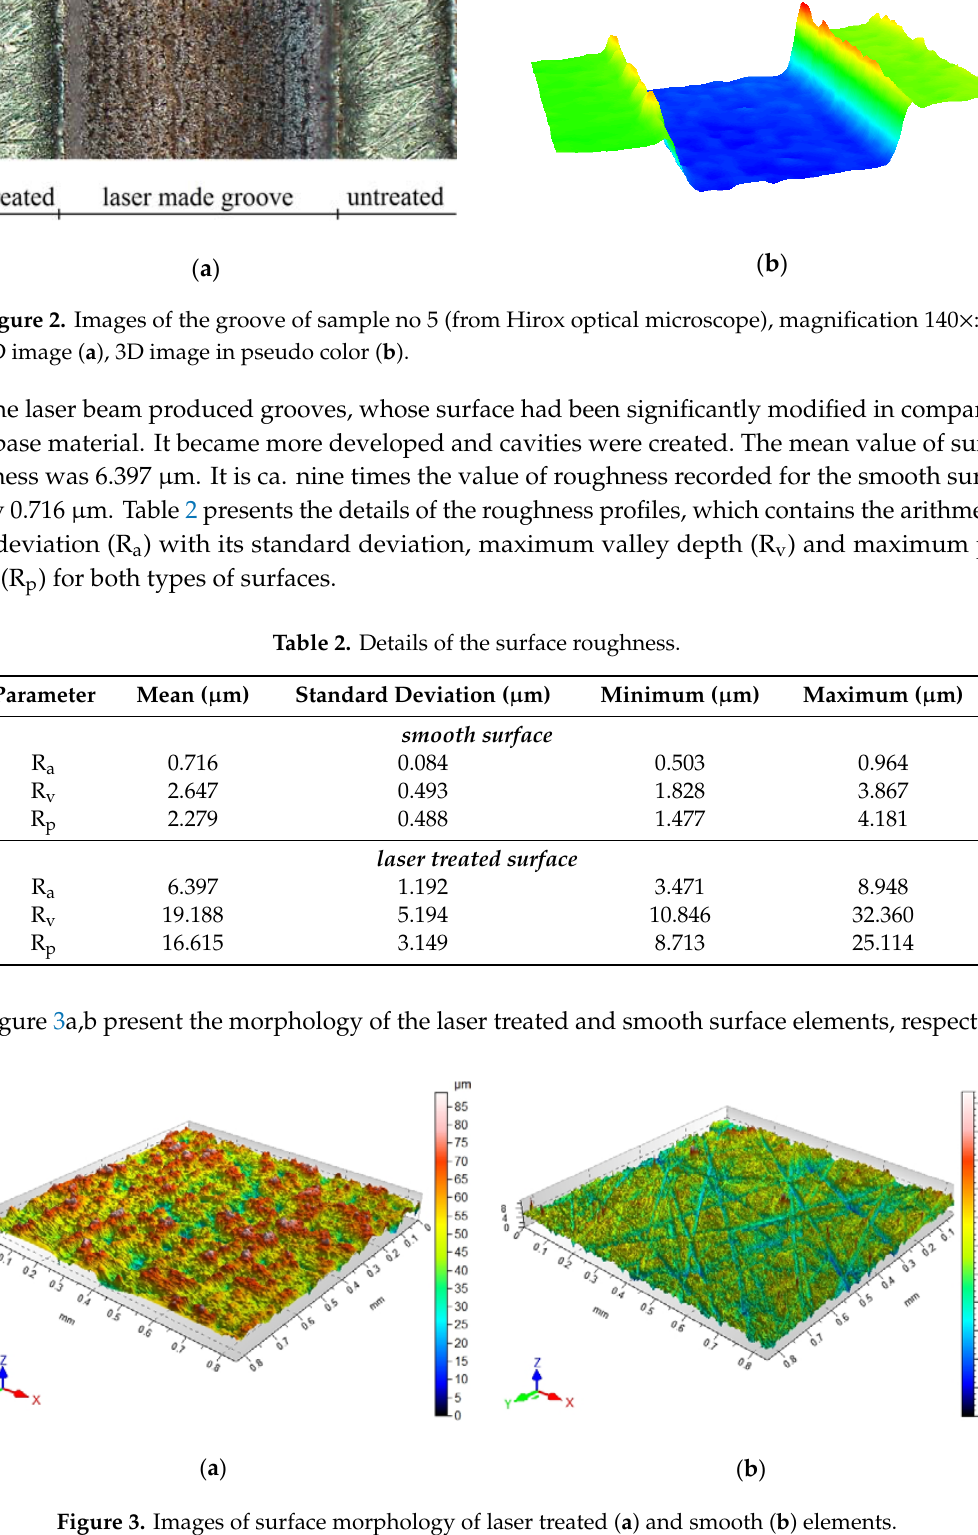
Figure 1. Laser treated sample. Schematic ( a ), picture of sample no 1 ( b ).